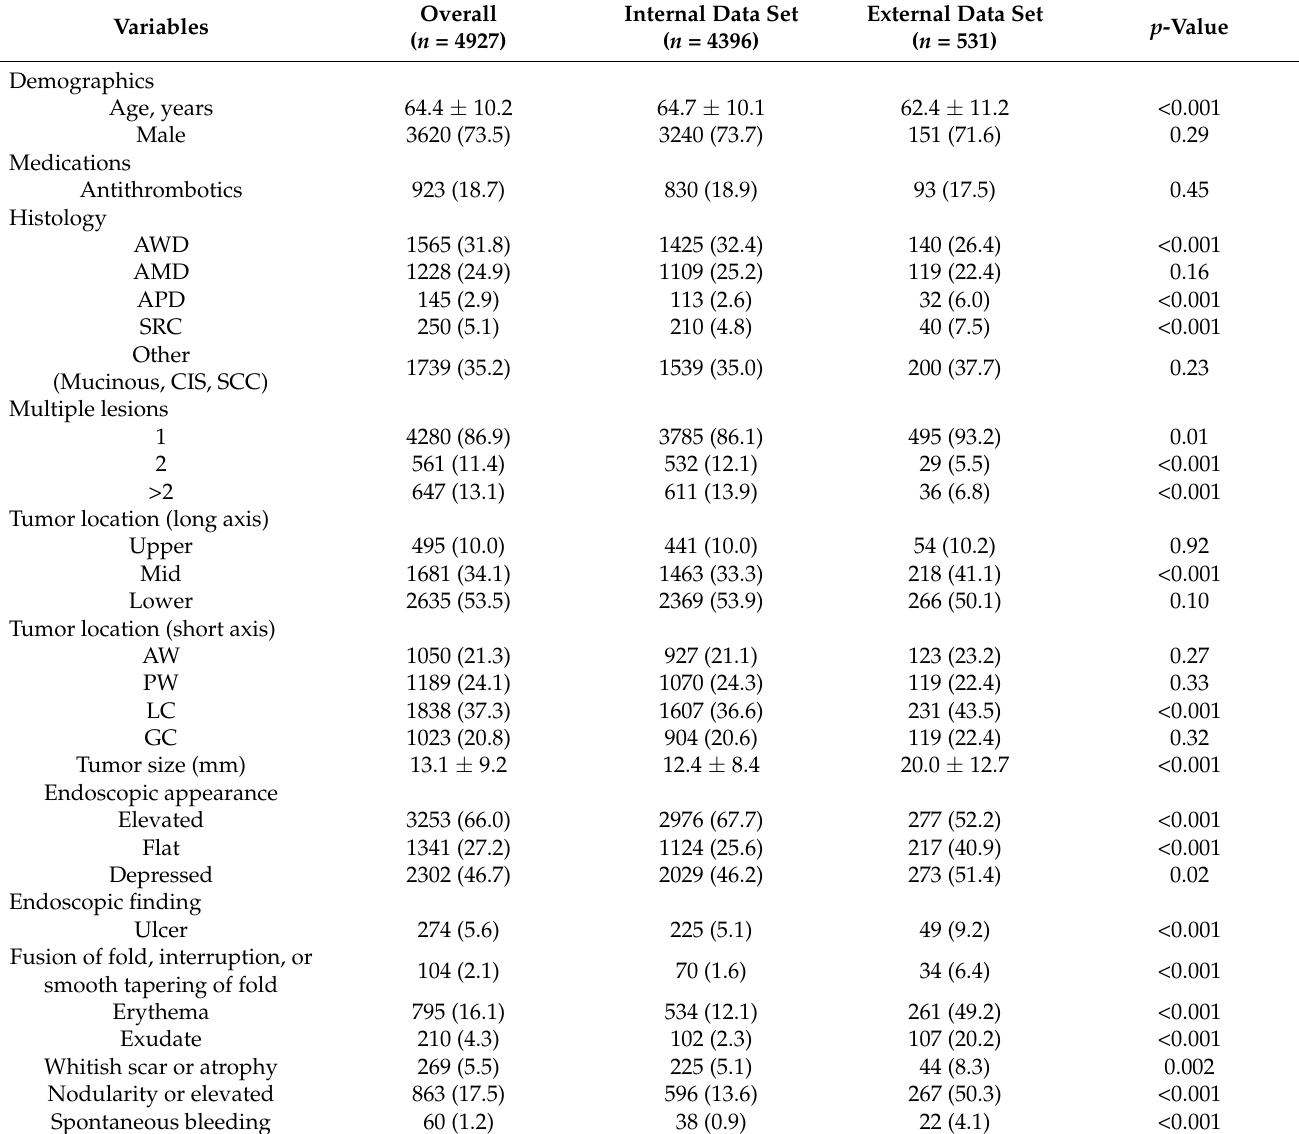
Table 2. Baseline characteristics of the internal and external data